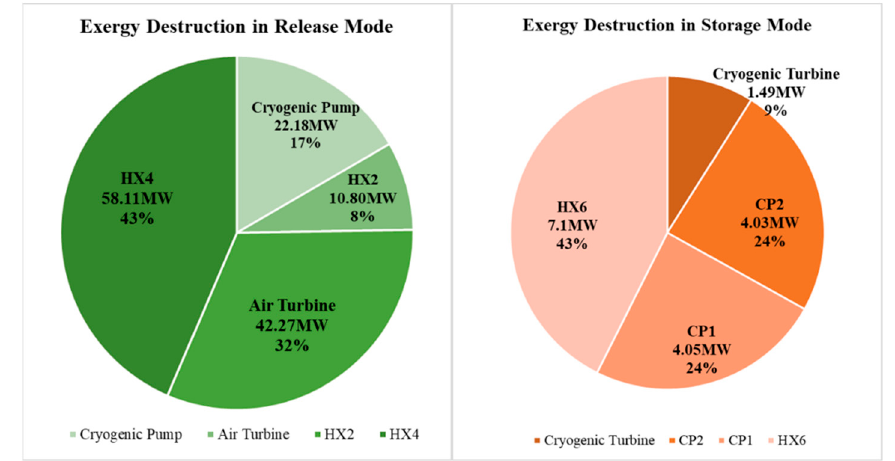
Figure 7. Exergy destruction in release mode ( Left ) and in storage mode ( Right ). Table 9. Performance summary for APR1400 integrated